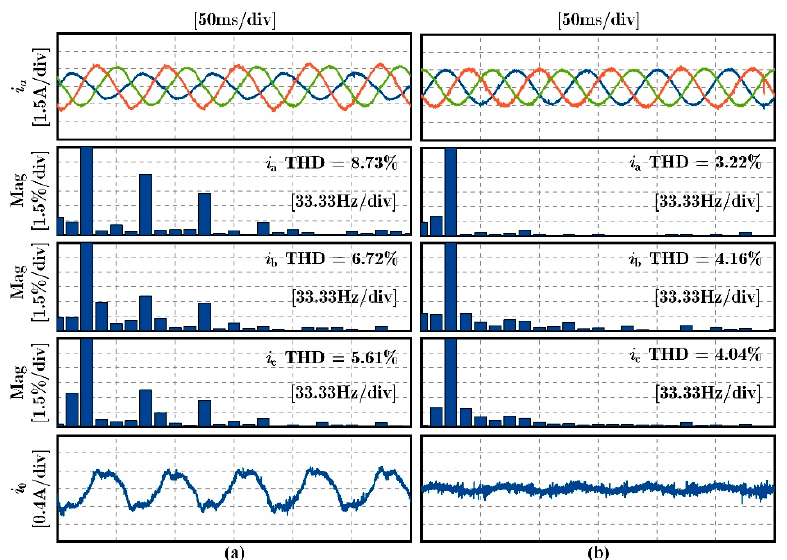
Figure 18. Experimental performance under 200 r/min: ( a ) comparison scheme (without zero- sequence loop control); ( b ) proposed scheme (with zero-sequence loop